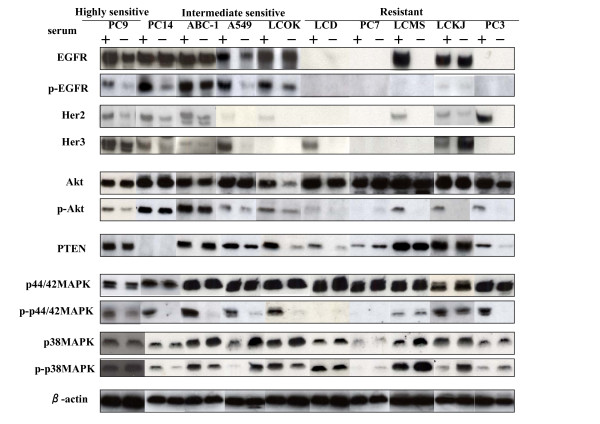
Western blot analyses: protein expression and phosphorylation of epidermal growth factor receptor (EGFR), Akt, PTEN, Her2, Her3, p44/42 mitogen activated protein kinase (MAPK), and p38 MAPK in adenocarcinoma cell lines cultured for 24 h with (+) or without (-) serum.